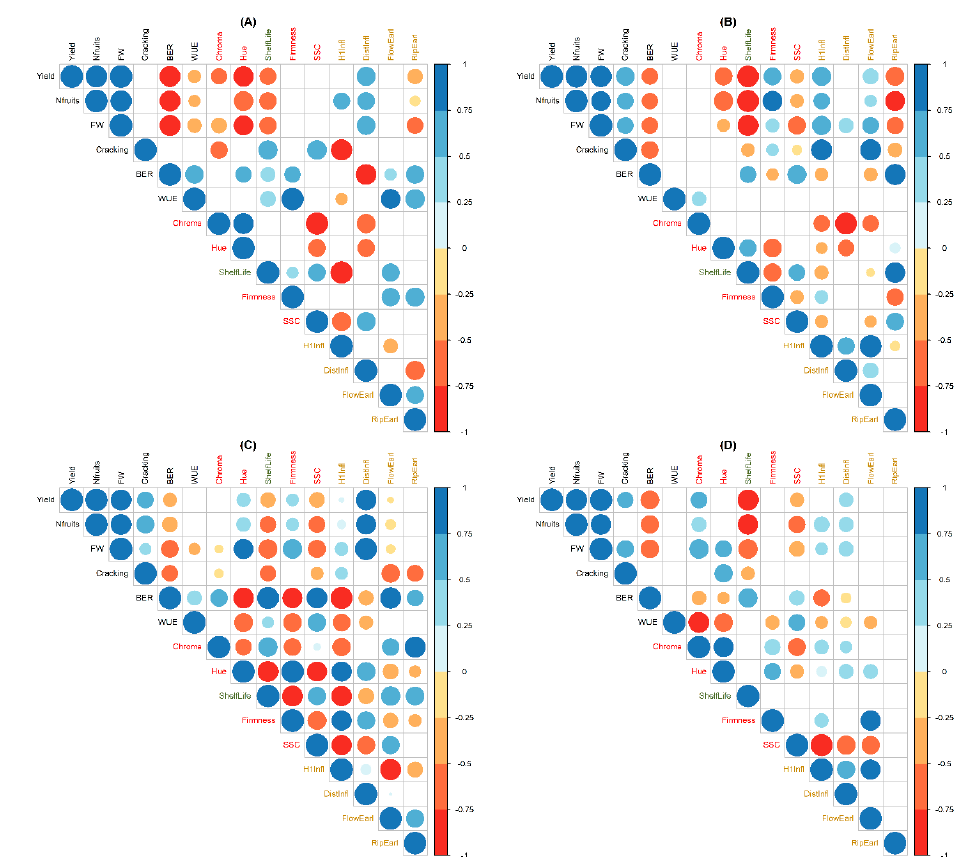
Figure 10. Correlation matrix for earliness, agronomic, fruit quality, and shelf-life traits in modern varieties ( A ) 545, ( B ) 15004, and landraces ( C ) LC649, ( D ) LC732, obtained in 2017 trials (n = 10). Colored boxes denote significant correlations ( p < 0.05), while uncolored boxes indicate nonsignificant correlations. The size of the circles is proportional to the correla- tion coefficients. The sign and the magnitude of the correlation are indicated by the colors according to the scale in the right panel. FW: fruit weight; Nfruits: number of fruits per plant; DistInfl: distance between inflorescences; H1infl: height of the first truss; SSC: soluble solids content; BER: blossom-end-rot; WUE: water use efficiency; ShelfLife: shelf life at 90 days. Name of the variables are colored by groups (black = agronomic traits; red = quality traits; green = postharvest shelf life; yellow = plant architecture and earliness traits).